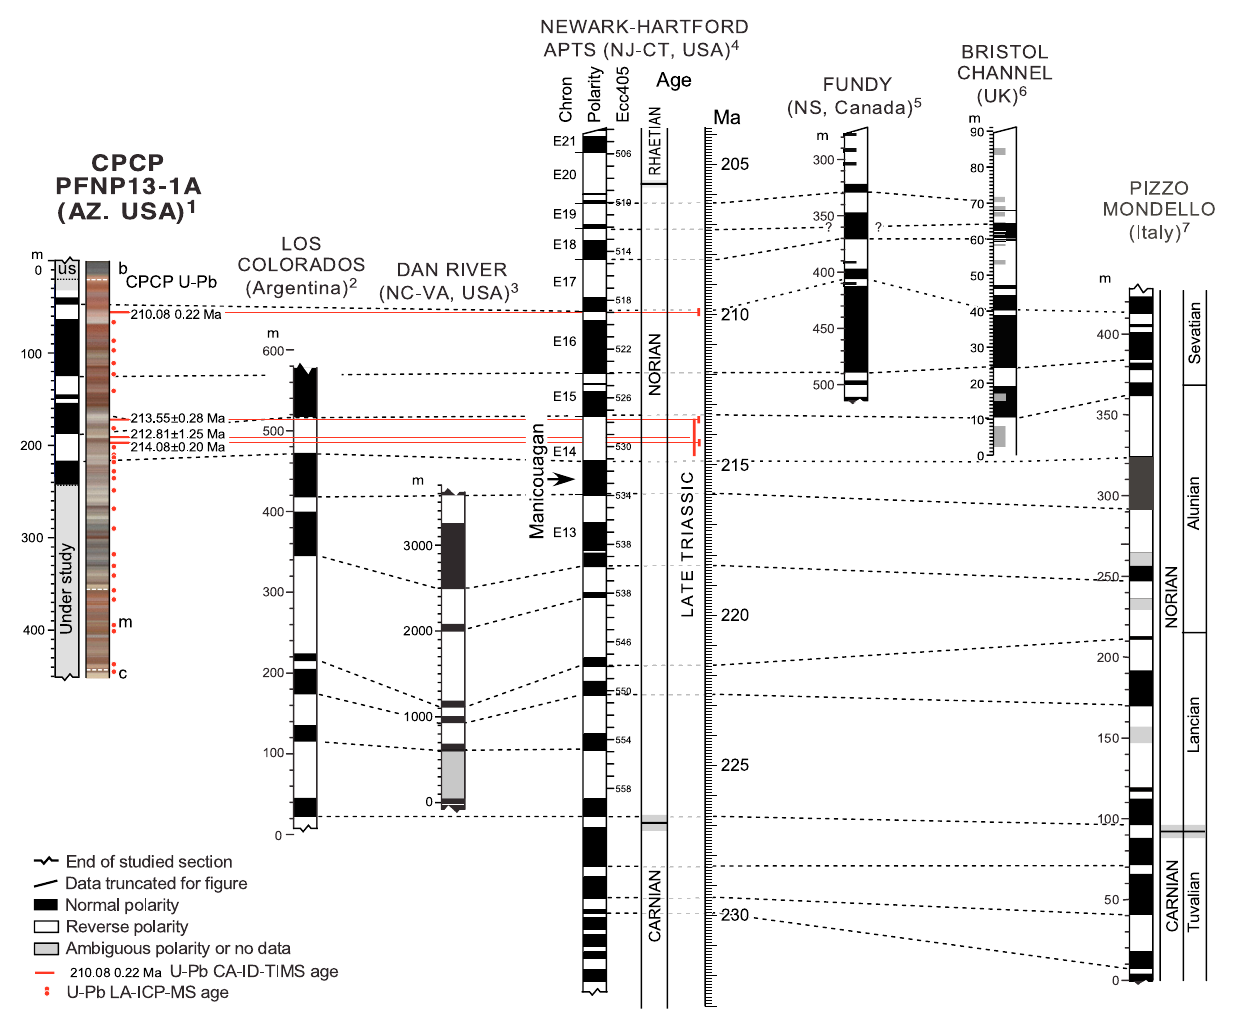
Figure 16. Paleomagnetic polarity stratigraphy of the upper part of the Chinle Formation in CPCP PFNP-13-1A correlated with the Newark- Hartford APTS and sections in Argentina, eastern North America (Dan River and Fundy basins), the UK, and Italy. Dotted white lines in the CPCP section are formation boundaries. Note that no correlation is implied for the Chinle Formation below 245m stratigraphic depth. Sections are shown in stratigraphic (thickness) coordinates, except the APTS, which is in time, pinned to zircon U-Pb dates from the Central Atlantic Magmatic Province (CAMP) (Blackburn et al., 2013) and tuned to the 405kyr orbital cycle. CPCP zircon U-Pb ages are correlated (horizontal red lines) with the Newark-Hartford APTS by paleomagnetic polarity stratigraphy and a linear age–depth model (Kent et al., 2018) (with the analytical error shown by the vertical red bars). Each paleomagnetic polarity stratigraphy is independently correlated in this diagram with the Newark-Hartford APTS via the first and last polarity boundaries according to the original author (not shown for the sections truncated here). Additional abbreviations are Ecc405, the Jupiter–Venus eccentricity cycle of a 405kyr period; us, unsampled; b, Neogene Bidahochi Formation; m, Early to nominally Middle Triassic Moenkopi Formation; and c, Early Permian Coconino Sandstone. Sources are 1 Kent et al. (2018); 2 Kent et al. (2014); 3 Kent and Olsen (1999) and Olsen et al. (2015); 4 Kent et al. (2017); 5 Kent and Olsen (2000);